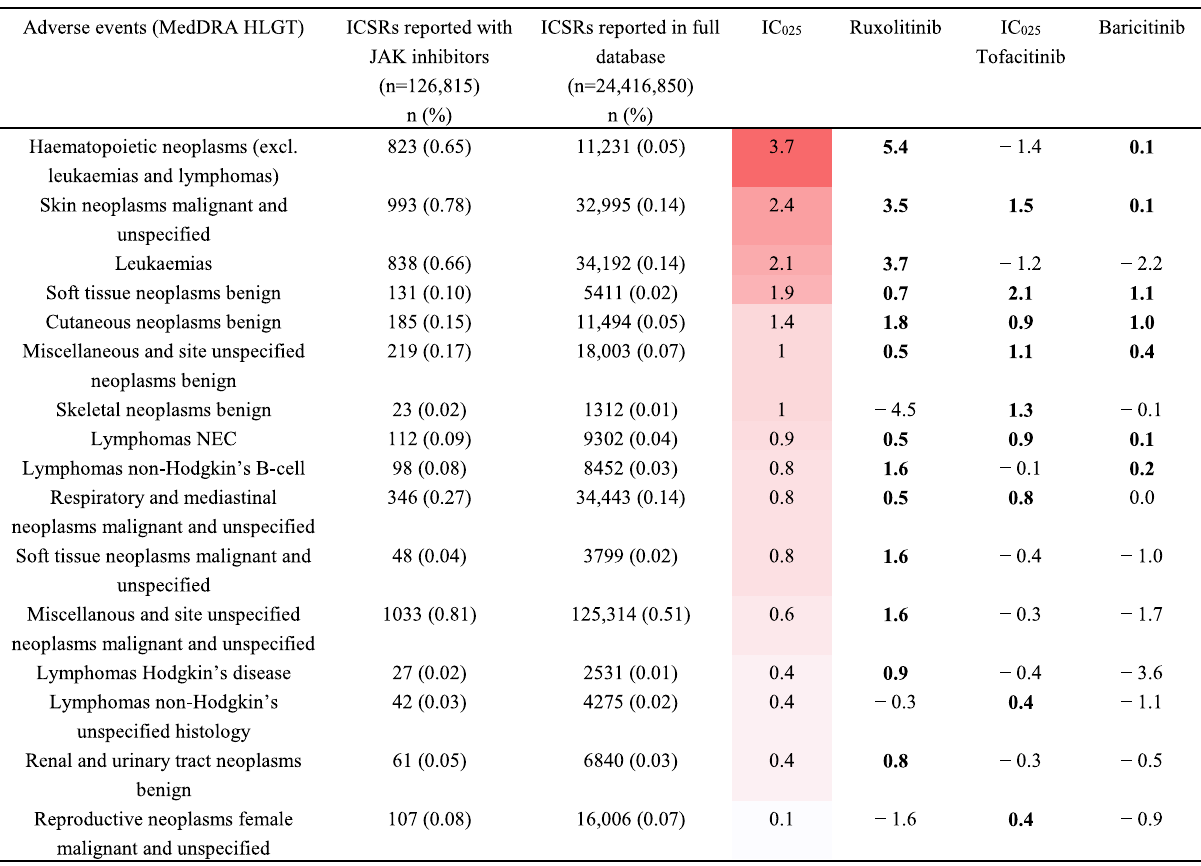
Table 2. Neoplasm adverse events related to JAK inhibitors. Significant values are given in